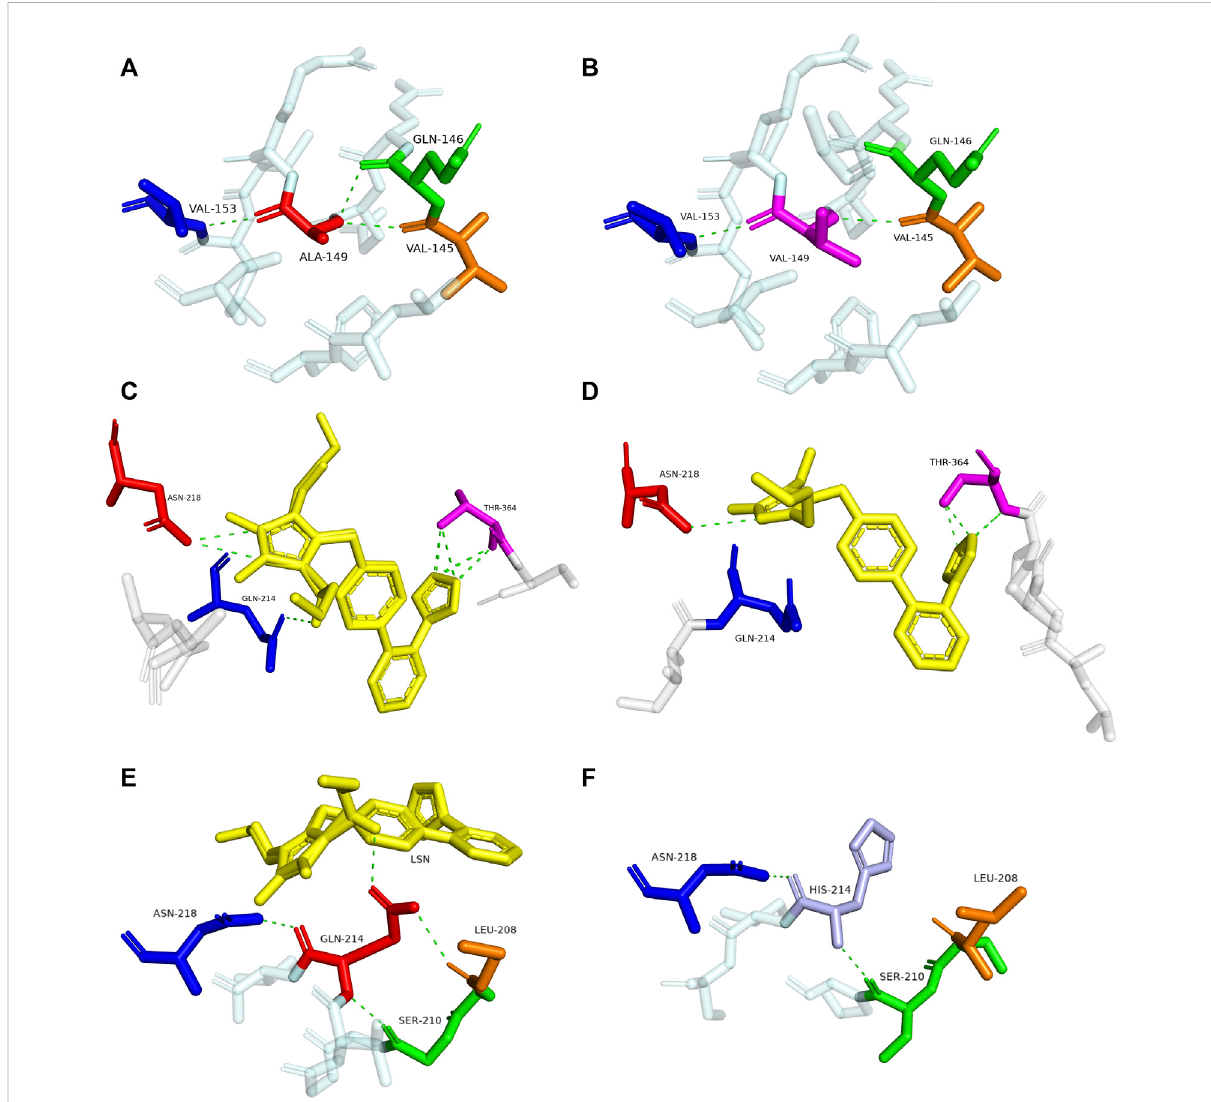
FIGURE 5 Magni fi ed view of the crystal structure of amino acids within 5 Å around themutatedsite of CYP2C9 variants and display of residues interacting withlosartan.Thehydrogenbondsareillustratedwithgreendashedlines.ReplacedresiduesofAla149inCYP2C9.72,Gln214inCYP2C9.74andtheir interacted residues are shown in (B,F) . Corresponding structures of CYP2C9.1 are also presented in (A,E) to illustrate the main difference between wild-typeenzymeandnewlydetectedvariants.Crystalstructuresoflosartan-interactingaminoacidresiduesinwild-typeCYP2C9.1andvariant CYP2C9.72aredisplayedin (C,D) ,respectively.Theligandlosartan isshownwithyellowcolorandthehydrogenbondsareshownwithgreendashed